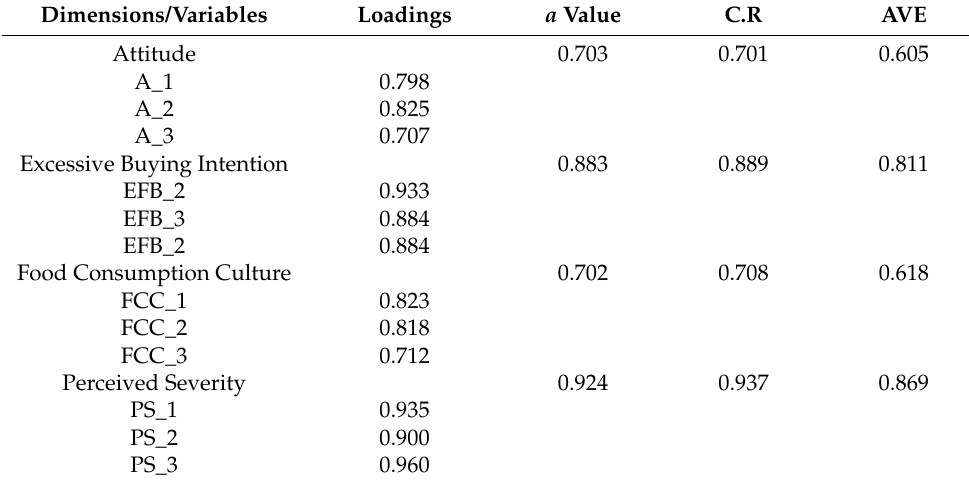
Table 1. Results of measurement